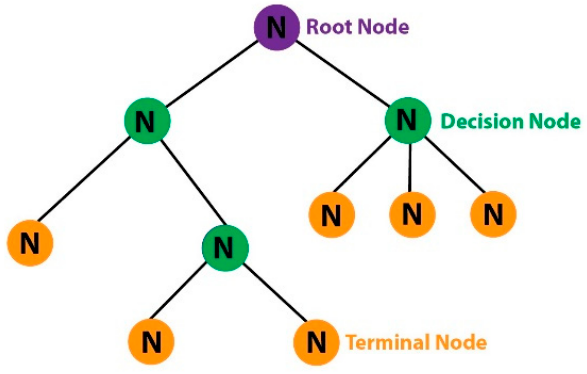
Figure 2. Decision Tree